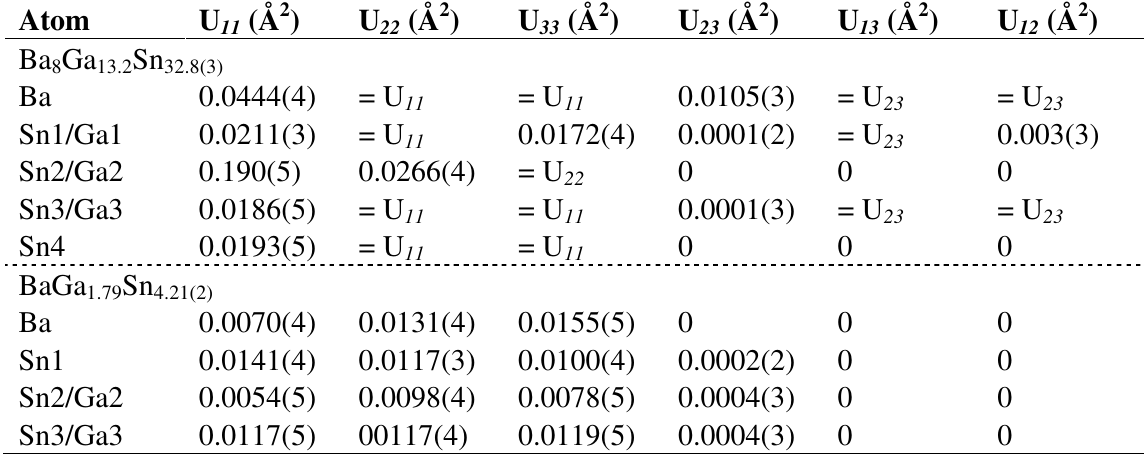
Sn and Ba Ga Sn 1.79 4.21(2) 8 13.2 32.8(3)